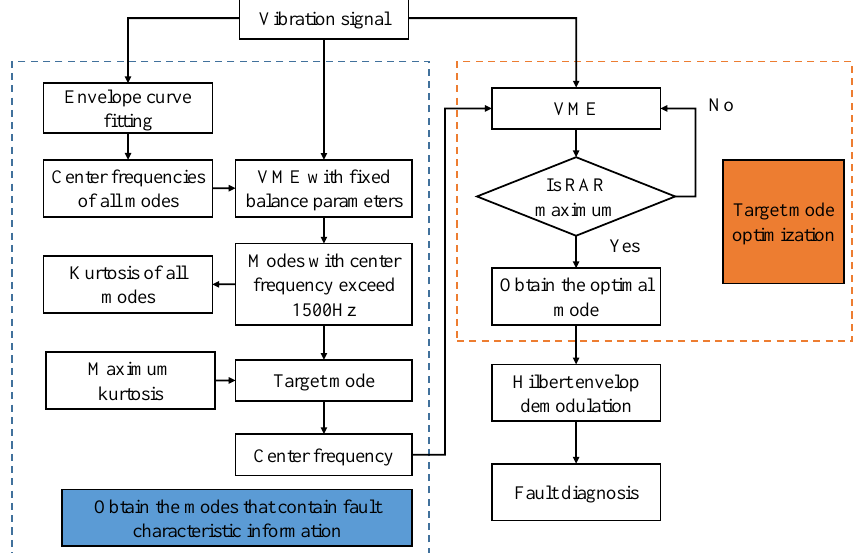
Figure 3. The flow chart of the proposed